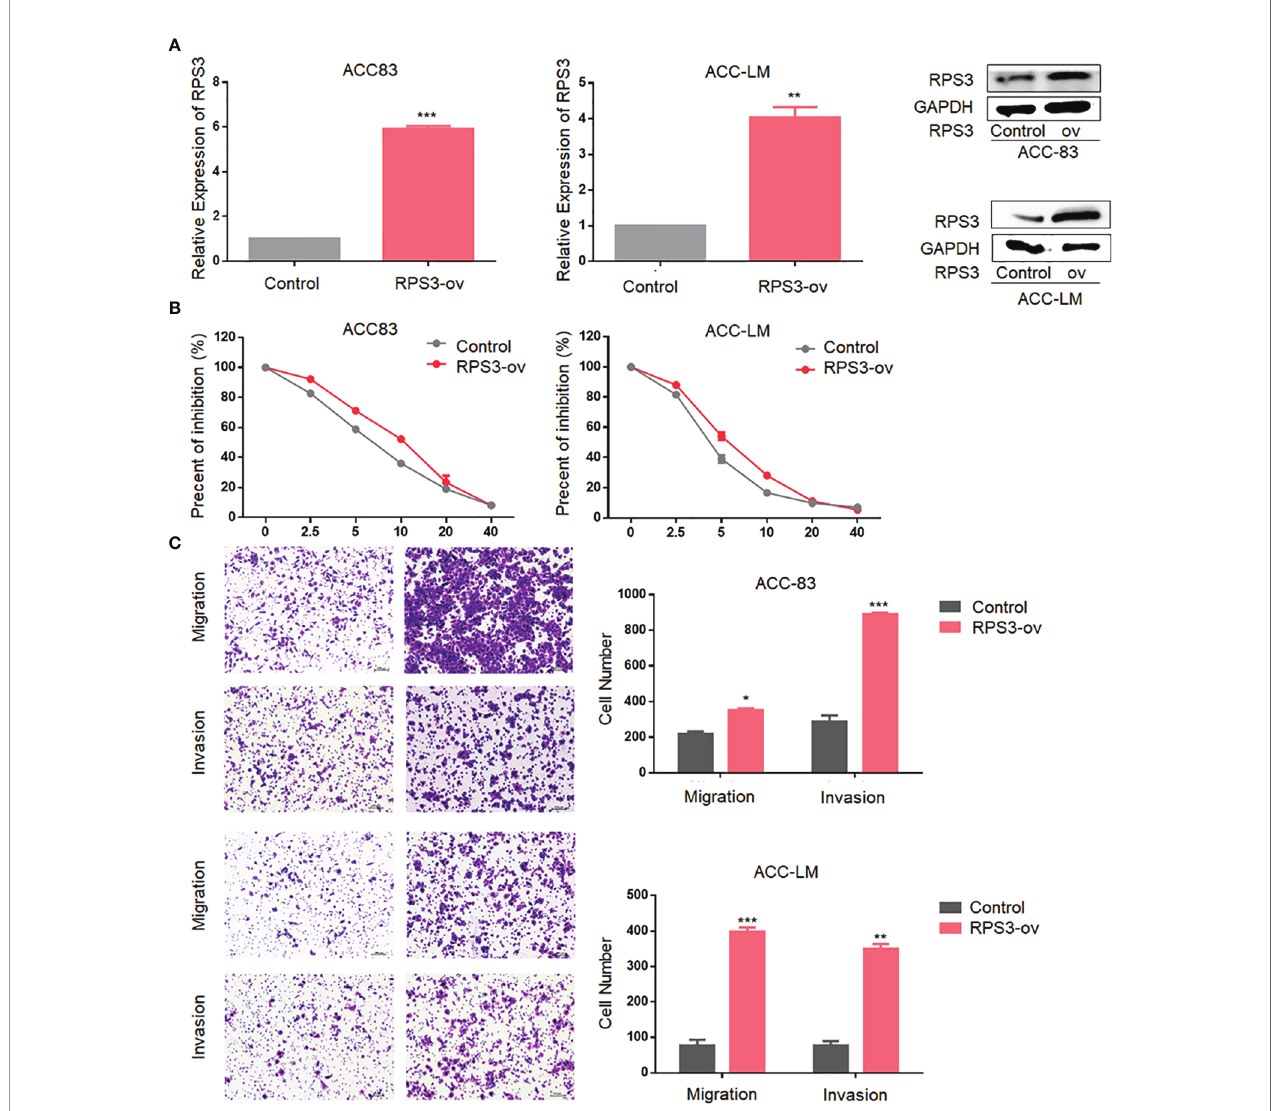
FIGURE 2 | Overexpression of RPS3 increased ACC migration, invasion and cisplatin resistance. (A) qPCR and WB experiments showed that the mRNA and protein levels of RPS3 were increased after transfection with plasmids in ACC-83 and ACC-LM cells. (B) IC50 experiments showed enhanced cisplatin resistance in ACC-83 and ACC-LM cells after RPS3 overexpression. (C) The Transwell assay results showed increased migration and invasion in ACC cell lines after RPS3 overexpression. *P < 0.05; **P < 0.01; ***P <